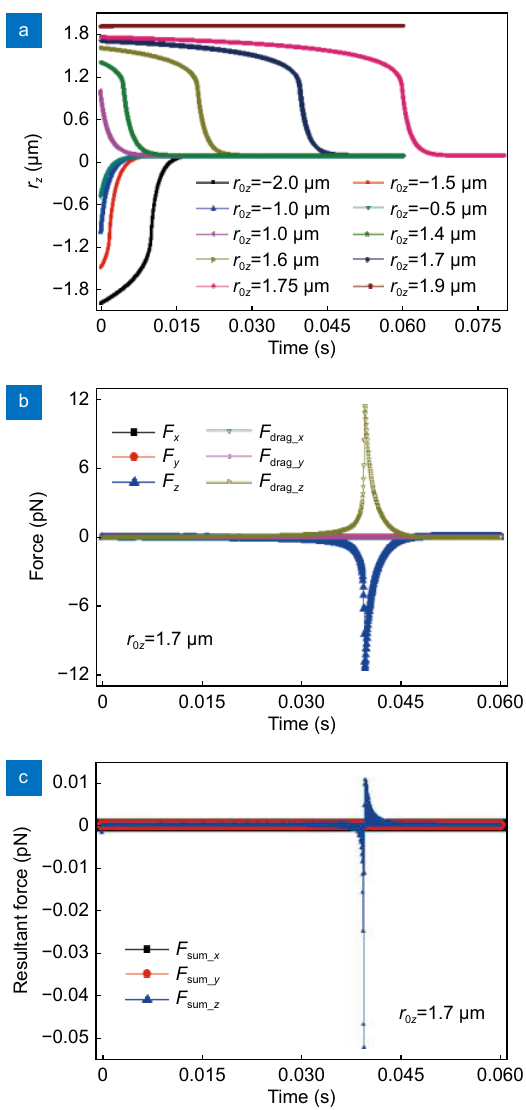
Fig. 5 | Mechanical motion dynamics of the micro-sphere at dif- ferent initial positions along the optical axis . ( a ) The z -directional trajectories of the micro-sphere at different initial positions in the z - axis in the optical tweezers with r 0 x =−2.0, −1.5, −1.0, −0.5, 1.0, 1.4, 1.6, 1.7, 1.75 and 1.9 μm. ( b ) and ( c ) The sketches of the optical force and the drag force, and the resultant force over time, respect- ively, when the micro-sphere is set at the initial position r 0 x =1.7 μm.